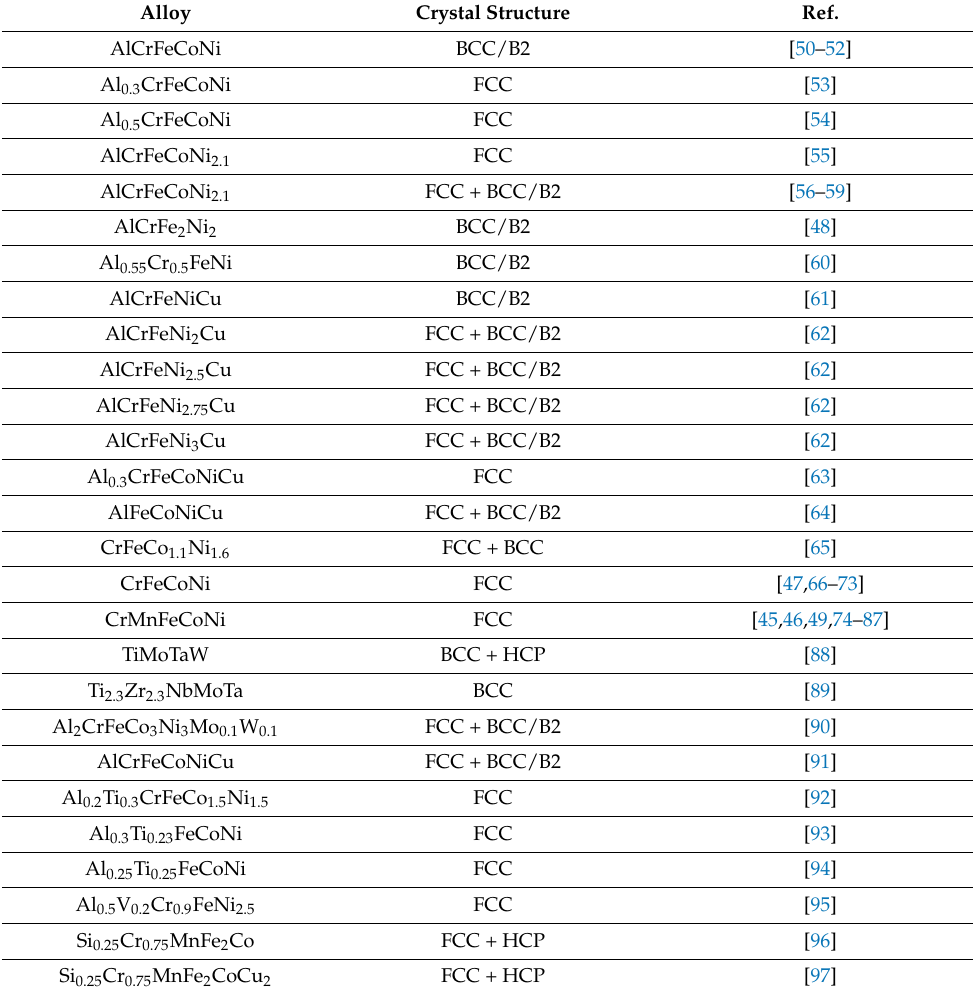
Table 1. HEAs fabricated by L-PBF process and pre-alloyed powders as feedstock material. Alloy Crystal Structure